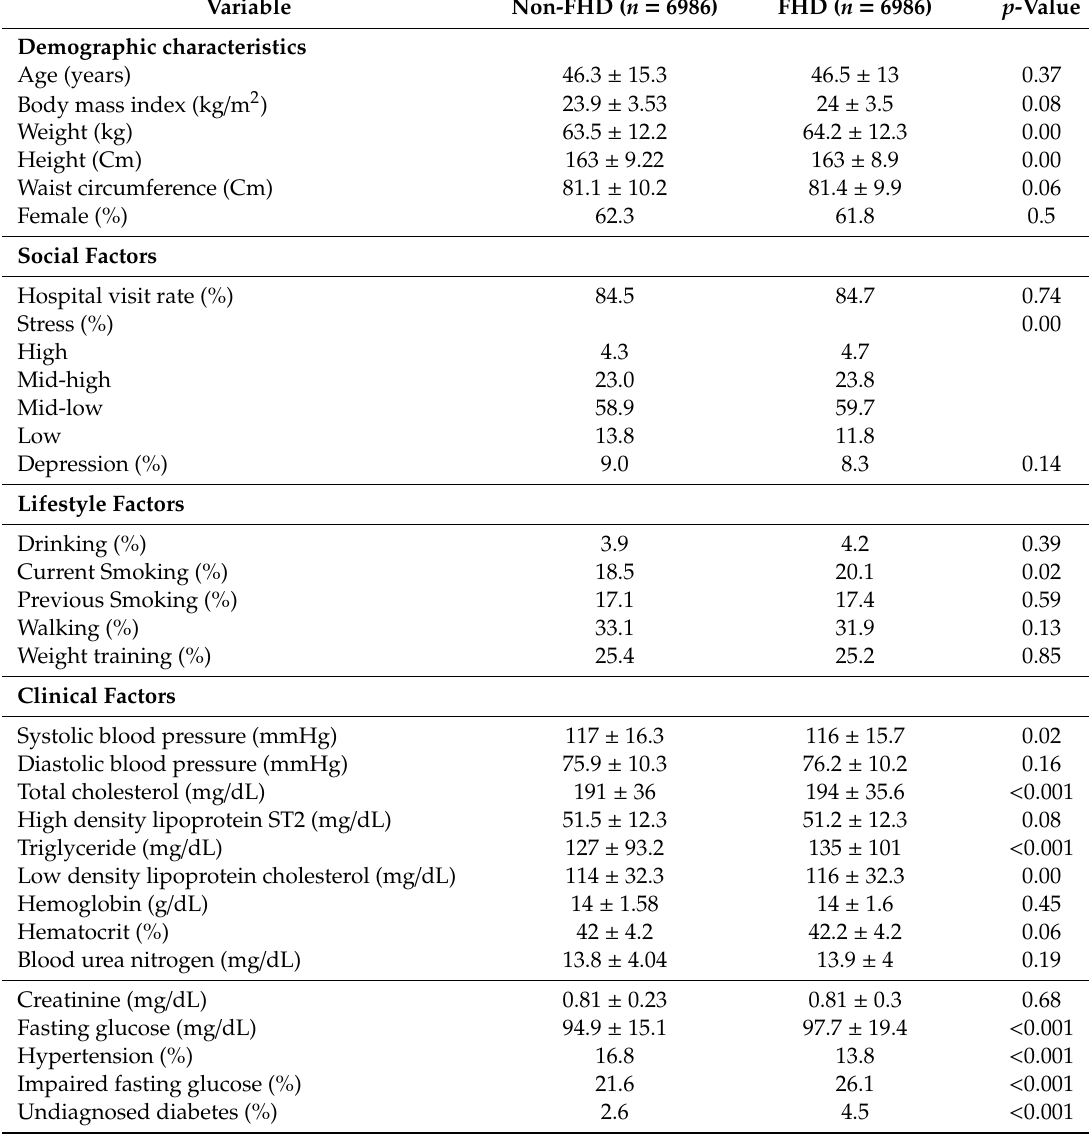
Table A1. Propensity score-matched baseline characteristics of people with (FHD) and without (non-FHD) family history of